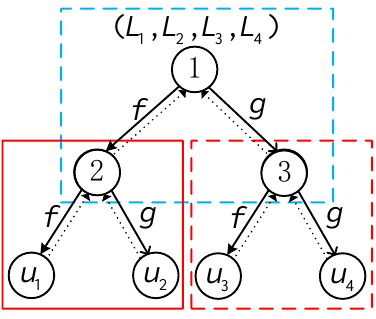
Figure 3. Polar code decoding tree diagram with length 4.